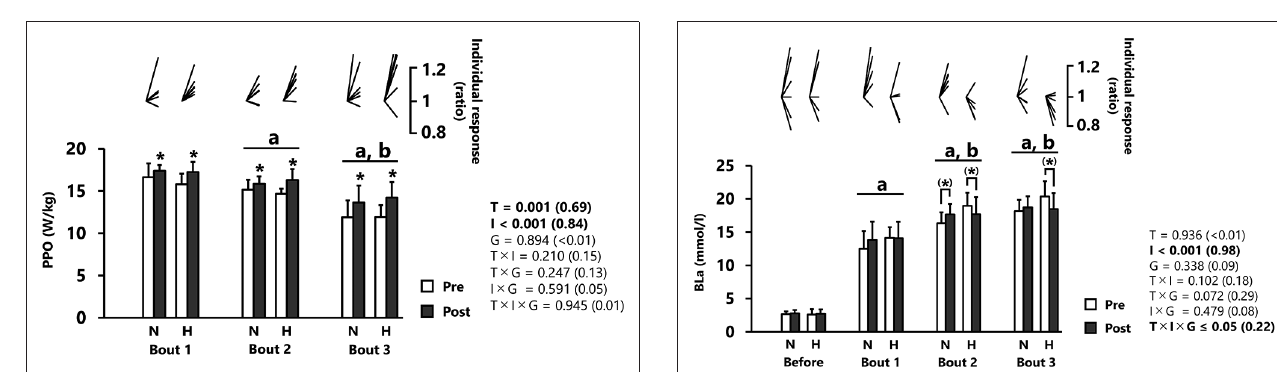
RPE was significantly increased after each successive repetition ( p < 0.001, d = 0.96), independently of group ( Figure 4 ). No main effect of training was reported for RPE values ( p = 0.675) Body weight did not differ ( p = 0.99) between pre-